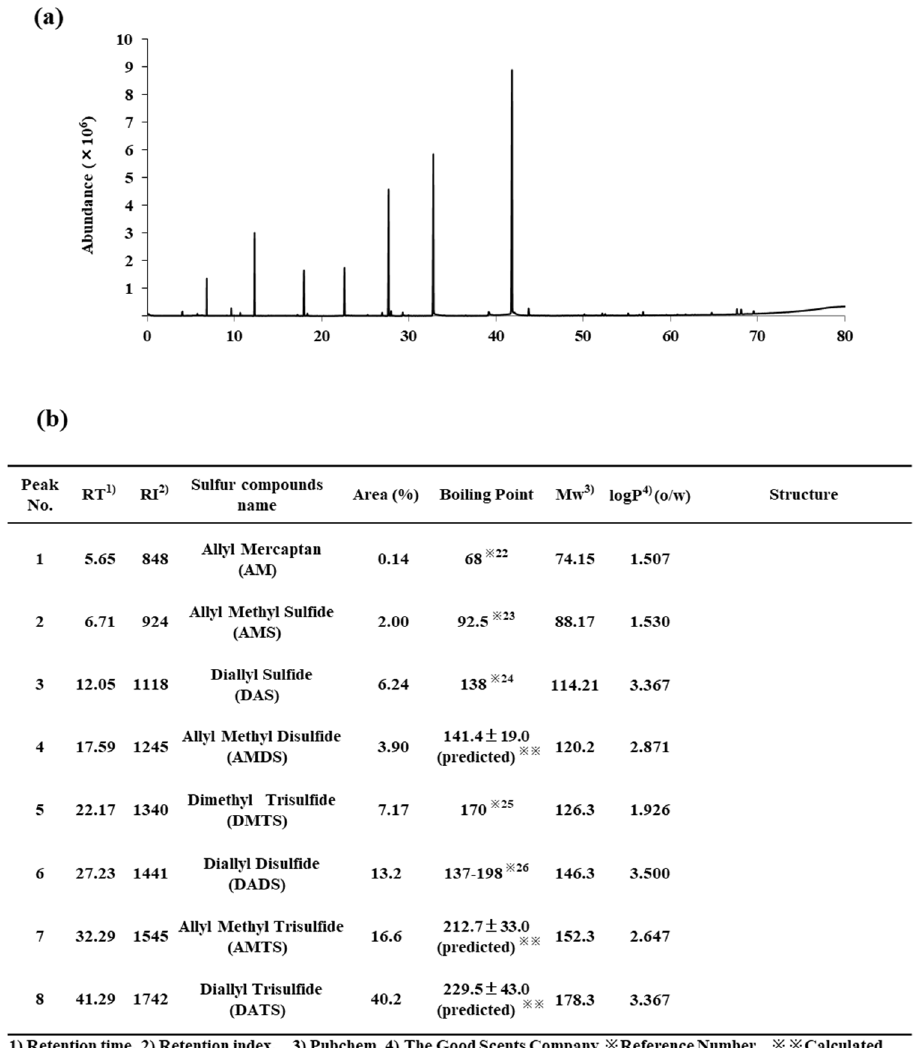
Figure 1. Organosulfur compound composition of GEO: ( a ) GC-MS total ion chromatogram, ( b ) contents and structures of organosulfur compounds in GEO.